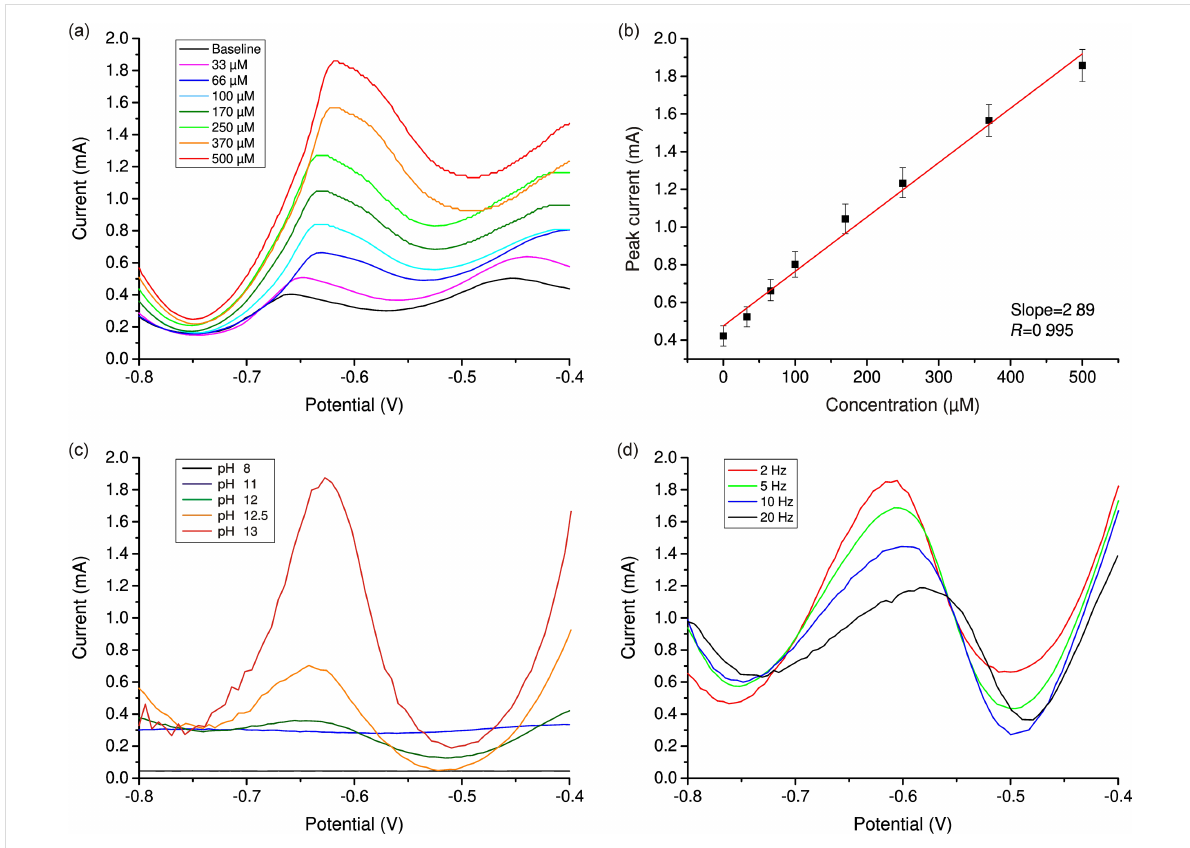
Figure 5: (a) DPV results for the nanostructured CuO electrode in 0.1 M NaOH buffer solution containing 33–500 μ mol H 2 O 2 . (b) Dependence of the amperometric response on the concentration of added peroxide (SD = 3.5%, n = 5). (c) Comparison of DPV curves obtained at different pH values of